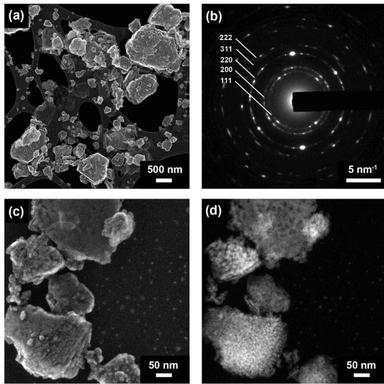
Electron microscopy characterization of the as-received NiO powder. (a) Low magnification secondary electron image of the powder suspended on a holey carbon support film. (b) Selected area electron diffraction pattern. High magnification (c) secondary electron and (d) high angle annular dark field images. Some of the NiO particles are composed of agglomerates of primary particles with diameter less than 10 nm.